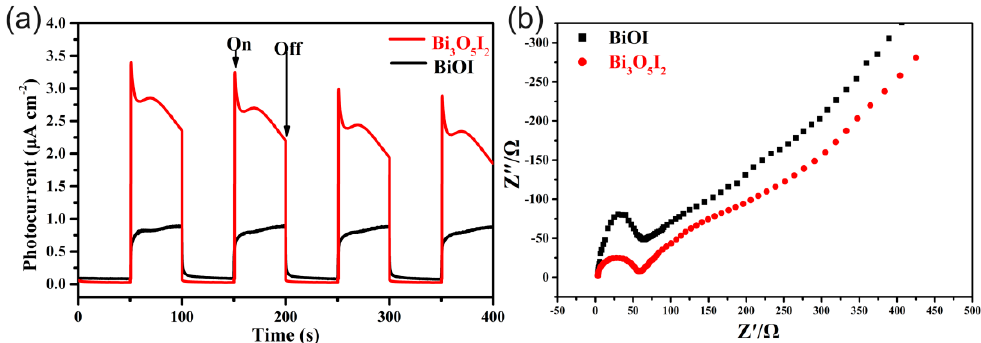
Figure 8. ( a ) Photocurrent responses of Bi 3 O 5 I 2 and BiOI in Na 2 SO 4 solutions, ( b ) electrochemical impedance spectroscopy of Bi 3 O 5 I 2 and BiOI.